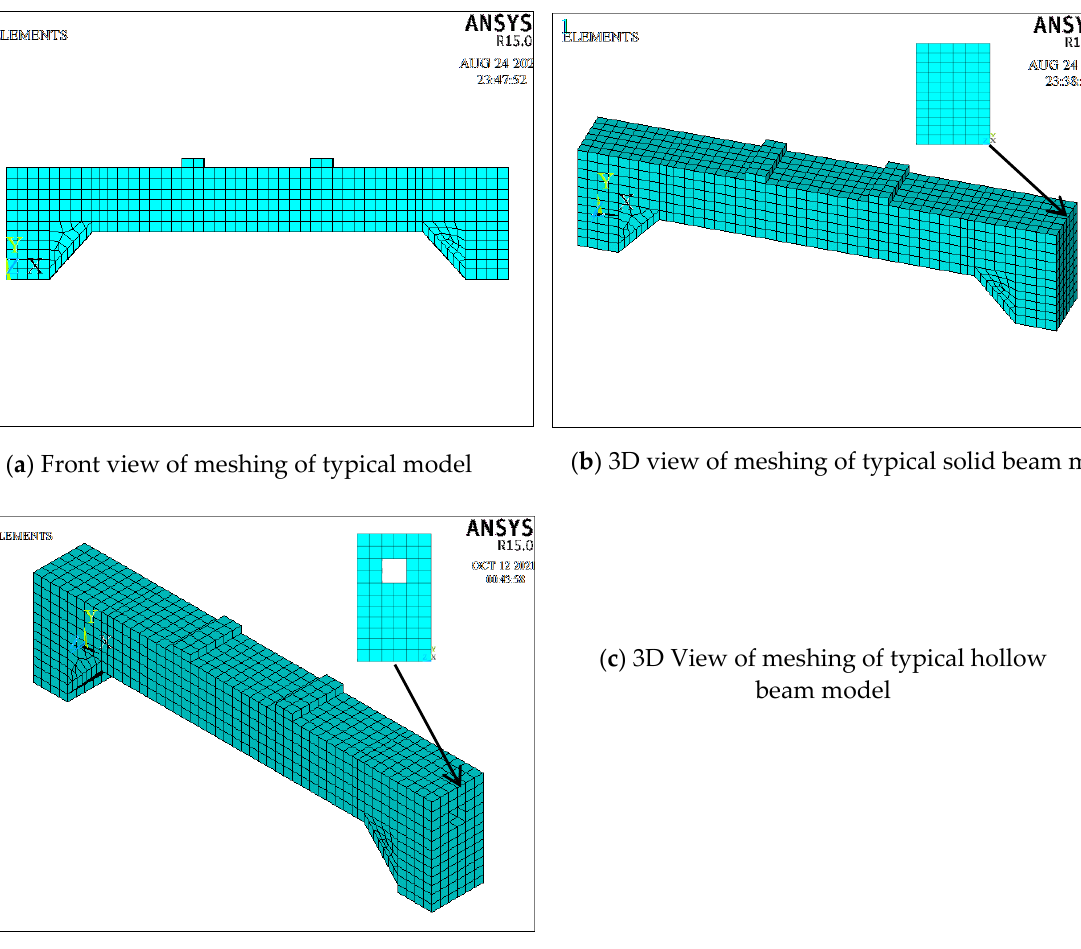
Figure 5. Meshing details of typical non-prismatic RC solid and hollow beam models.